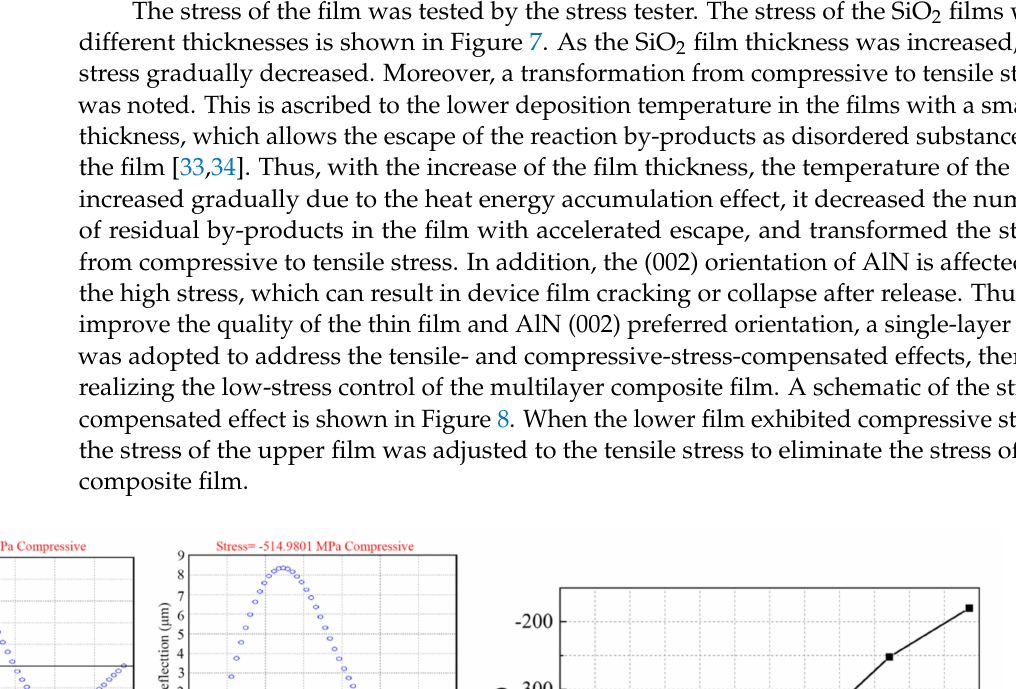
Figure 9. The FWHM of the AlN (002) swing curve was reduced from 2.361 ◦ to 1.885 ◦ after optimization, and the surface had a high peak strength, indicating the c-axis orientation and good crystallization of the AlN film